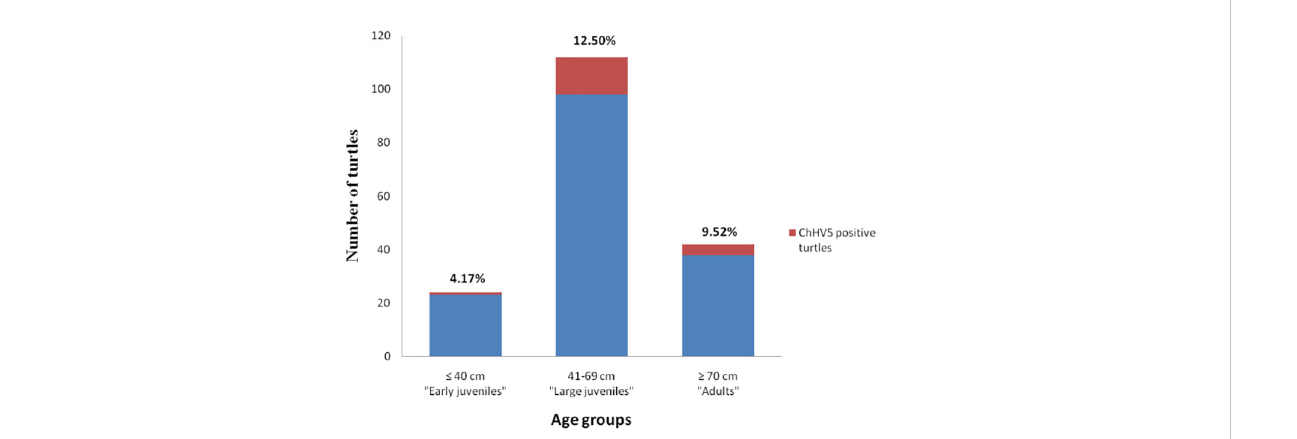
FIGURE 4 Prevalence of ChHV5 in the different age groups of sea turtles analysed. Histogram indicates the total number of turtles belonging to the age group, while the red part of it indicates the number of turtles positive for the virus.